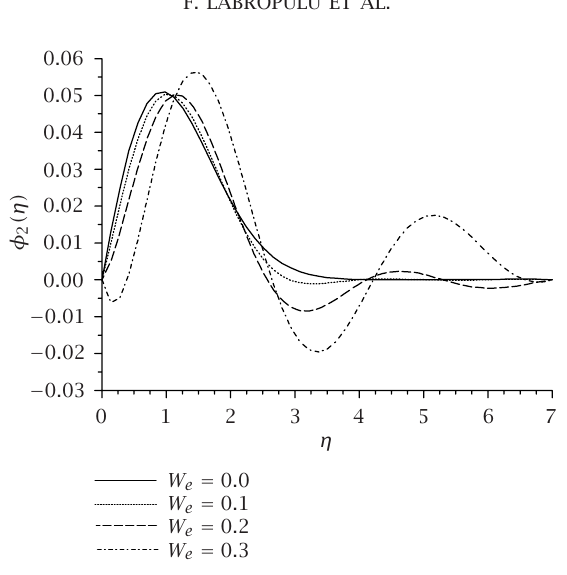
Figure 3.5 . Variation of φ